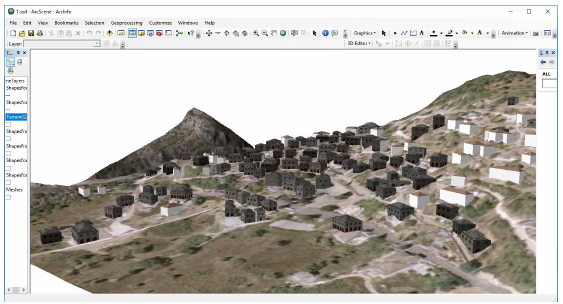
Figure 13. 3D model of the case study area, ArcScene.